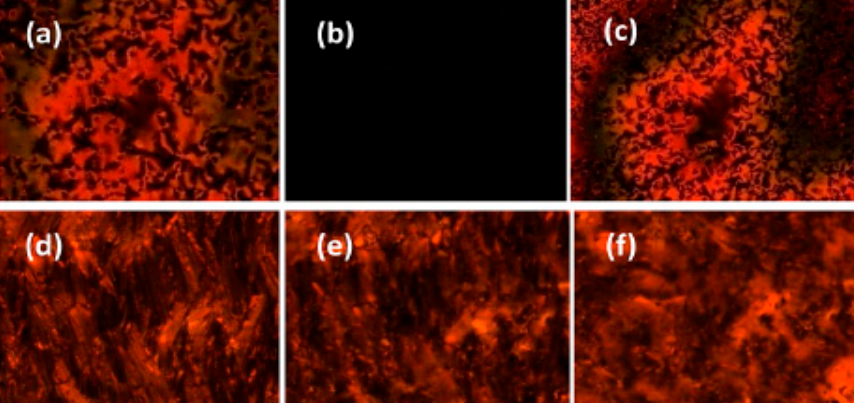
Figure 22. The photoinduced phase transition of compound 63b observed under POM with a red filter, ( a ) the nematic phase upon cooling to T = 113 °C before the UV illumination, ( b ) transition to isotropic state at T = 113 °C upon the UV irradiation with λ = 365 nm, ( c ) recovered nematic phase when the UV light is removed, ( d ) the SmA phase at T = 94.9 °C, ( e ) the coexistence of SmA and nematic phase under the UV light exposure at T = 94.9 °C, and ( f ) conversion to the nematic phase at 94.9 °C (Reproduced with permission from ref. [153], copyright American Chemical Society 2019, https://doi.org/10.1021/acs.jpcb.9b01456).